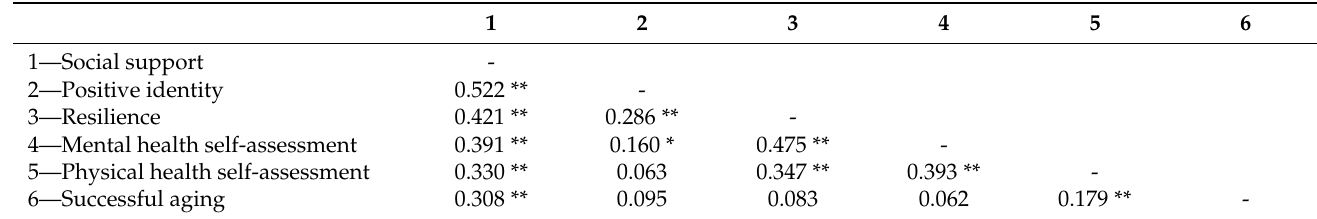
Table 3. Correlation values among variables.